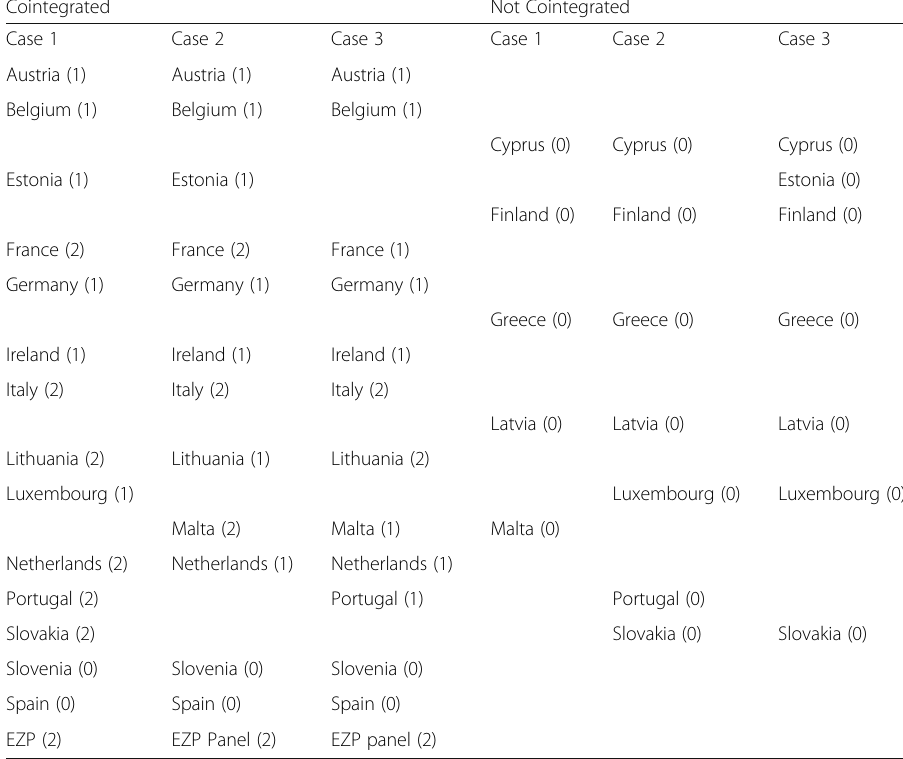
Table 4 Summary of Cointegration Test Results Cointegrated Not Cointegrated Case 1 Case 2 Case